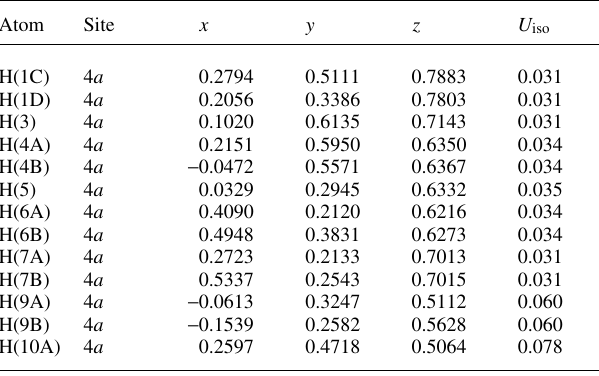
Table 2. Atomic coordinates and displacement parameters (in Å 2 )